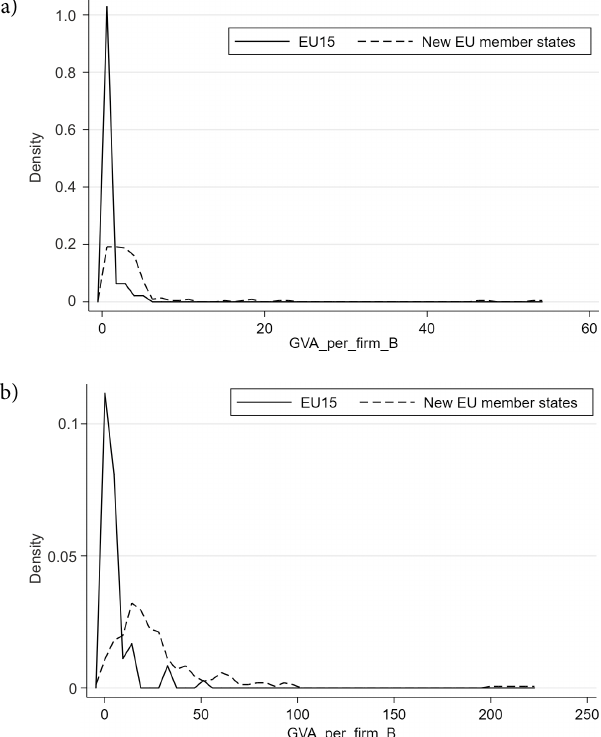
Figure 8. Comparative analysis of kernel density estimate distributions for countries in EU15 and new EU member states in Manufacture of computer, electronic, and optical products (a) and Manufacture of basic pharmaceutical products and pharmaceutical preparations (b) (source: computation based on Stata